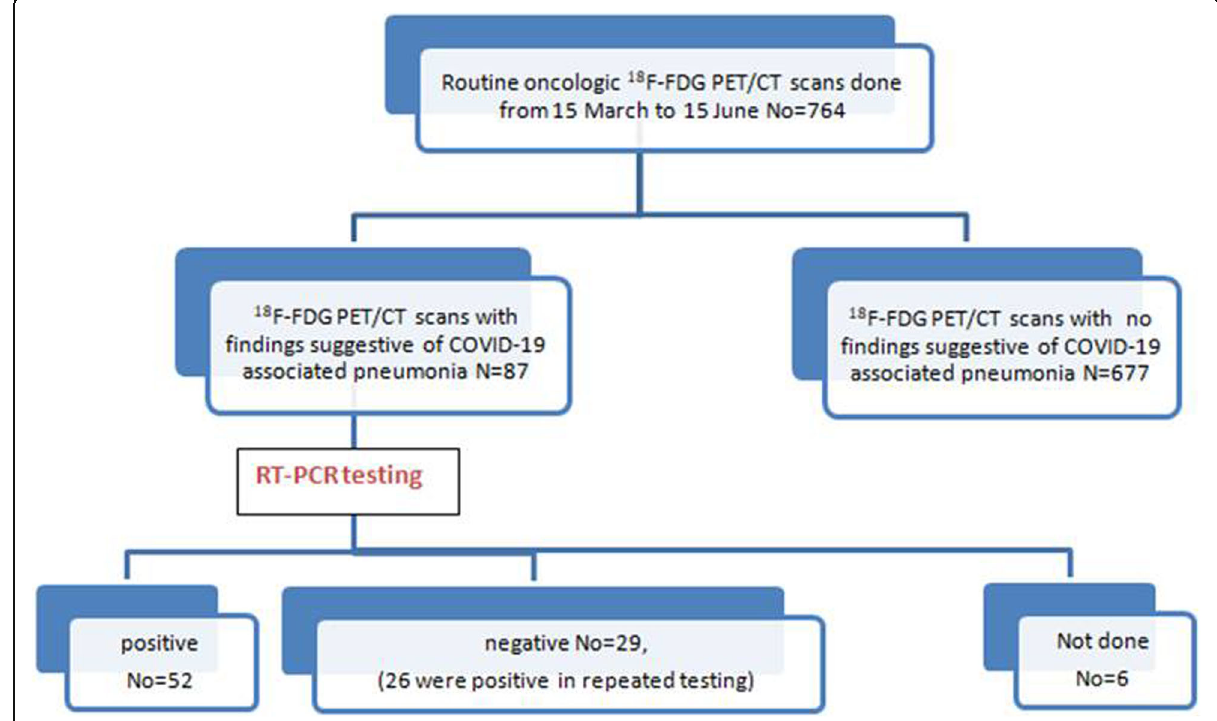
Fig. 9 Flow chart representation of the research methodology and